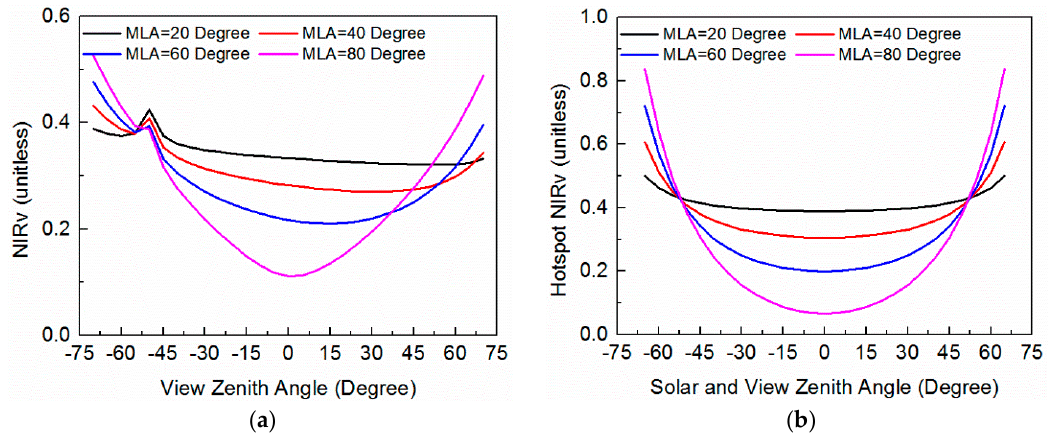
Figure 8. The reflectance simulated by the SIP model in the red band ( a ) and NIR band ( b ) at different mean leaf inclination angles (MLA) in the principal plane. The LAI is 1, and the solar zenith angle is 30°. The other input parameters are the same as Table 1.